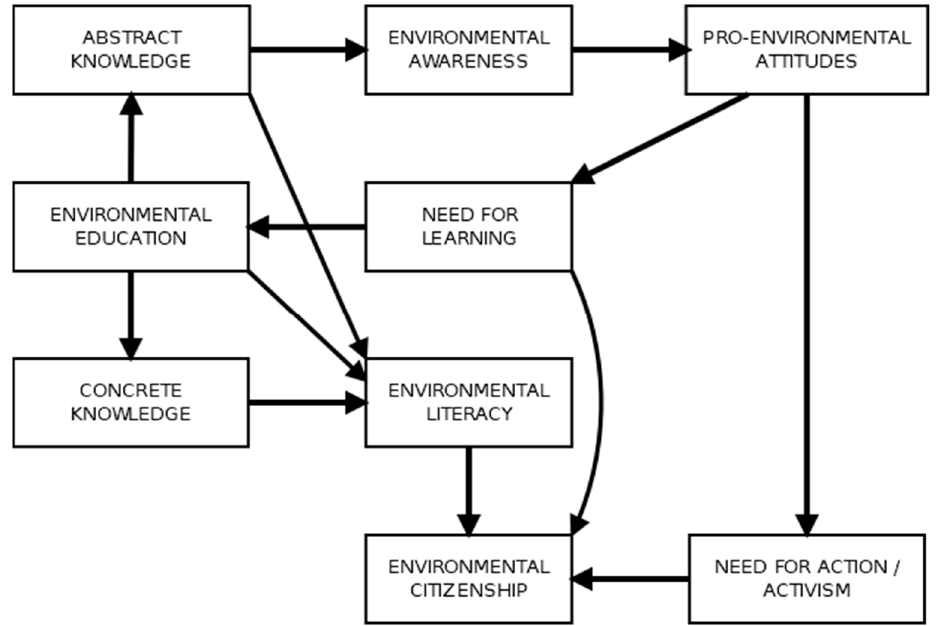
Figure 1. The Simple Model of Environmental Citizenship.